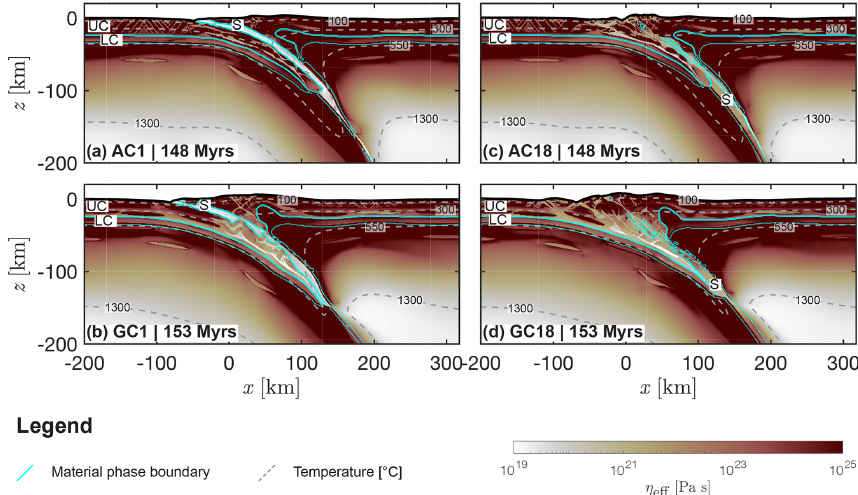
Figure 7. Plate-interface and upper crustal-matrix strength for models AC1, AC18, GC1 and GC18. White to dark red is the effective viscosity field calculated by the numerical algorithm. (a, b) Weak interface (AC1 and GC1), (c, d) strong interface (AC18, GC18). Grey dashed lines are several isotherms, cyan solid lines are material phase boundaries. Abbreviations: UC = upper crust, LC = lower crust and S = serpentinites. Low viscosity of serpentinites indicates weak plate interface (a, b) . For high viscosity the serpentinites are coupled to the lower plate and subducted into the mantle (c, d) . For a wet anorthite upper crustal matrix (a, c) the brittle-ductile transition (depth of plastic shear bands) in the upper crust is at greater depth compared to a Westerly granite upper crustal matrix (b, d)